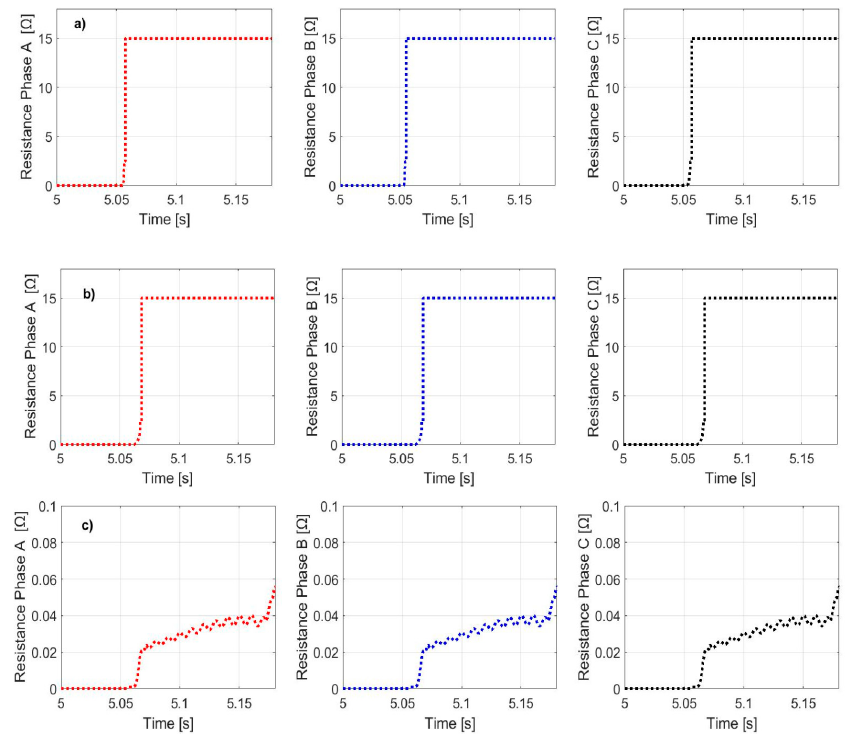
of phase B, ( g ) current in HTS layer of phase C, ( h ) current in copper slayer of phase C.